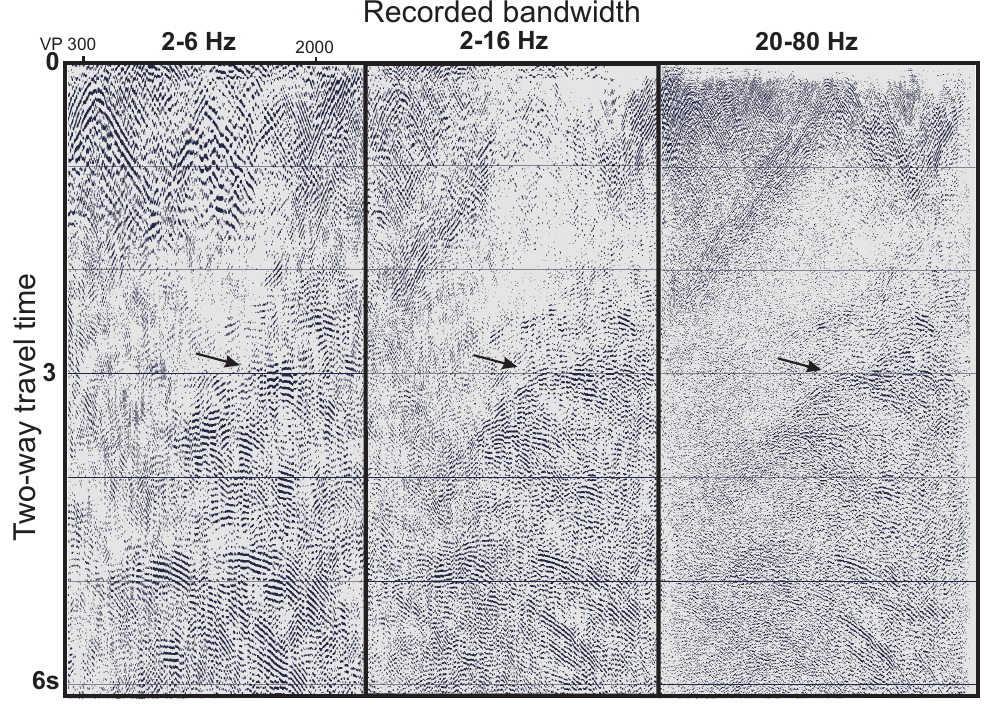
Figure 2. Recorded seismic frequencies as illustrated by band-pass sections. The ranges on top of the plots indicate the band-pass frequencies allowed. Note that high-amplitude reflections recorded in traditional band-pass ranges are also observed at frequencies less than 6